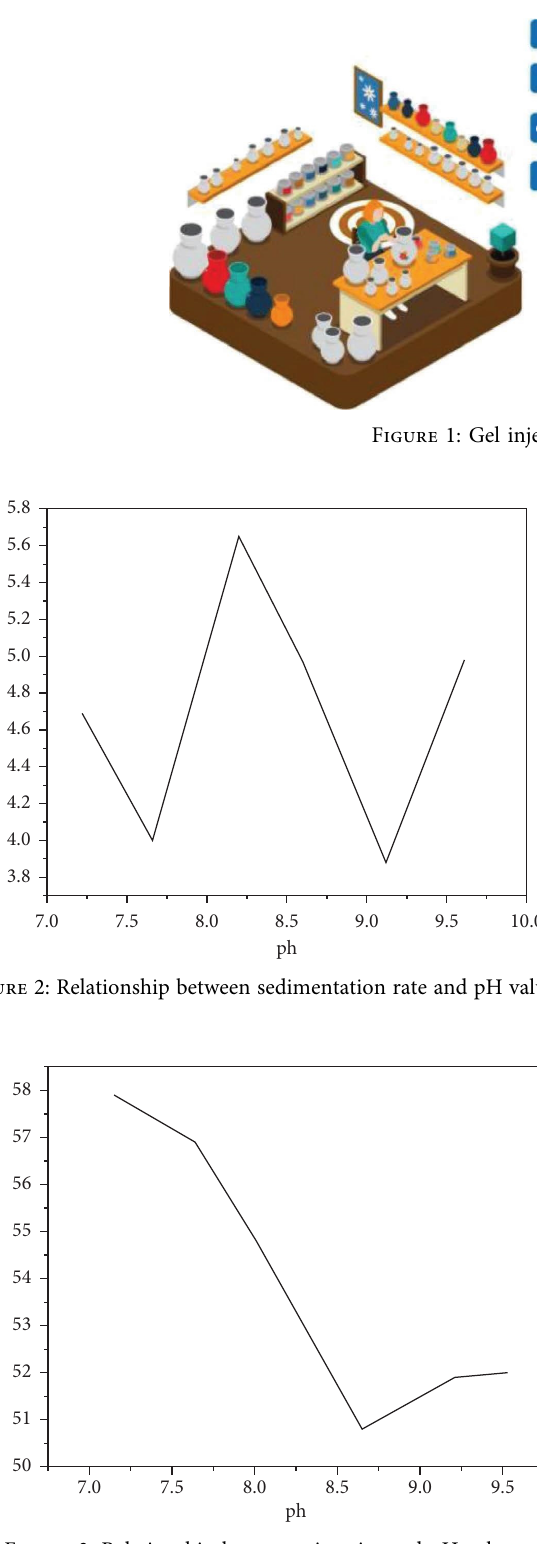
Figure 5: Relationship between viscosity and mass fraction of